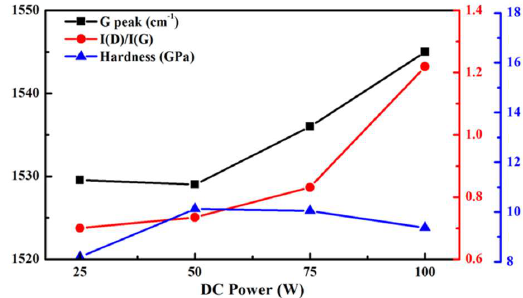
Figure 2. The analysis of DLC properties in the RF bias range of 200–400 V ( a ) with, and ( b ) without DC power of 50 W with CH 4 flow rate of 15 sccm. (CH 4 = 15 sccm, thickness: (a) 470 nm and (b) 110 nm).